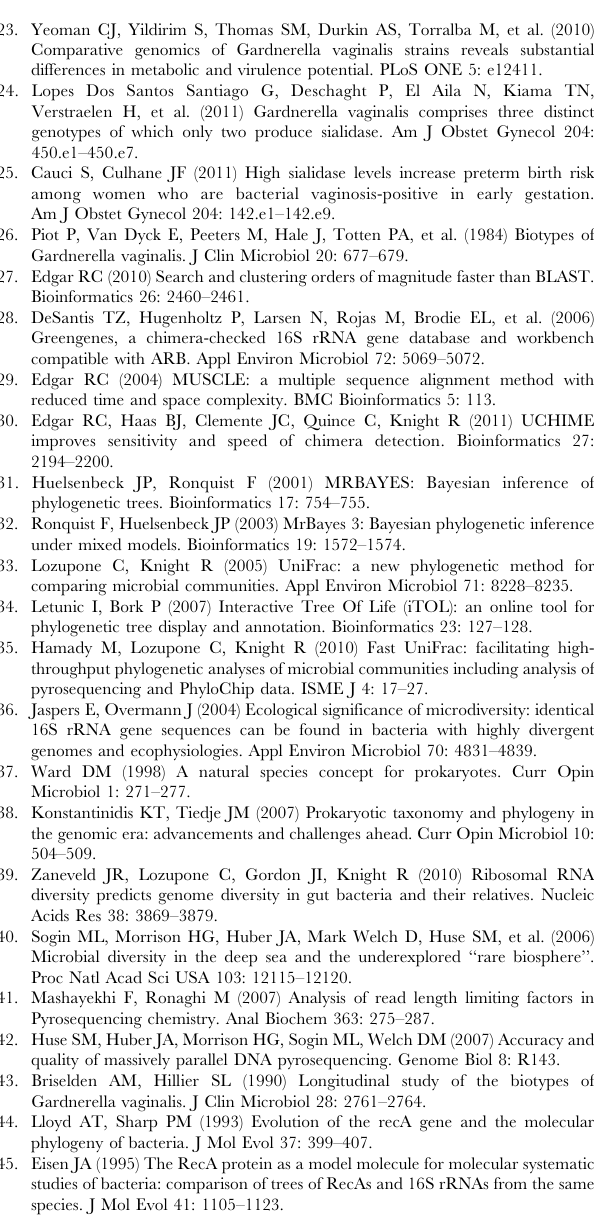
samples are shown in parentheses in all three groups of Gram Stain (GS) BV, GS Intermediate and GS